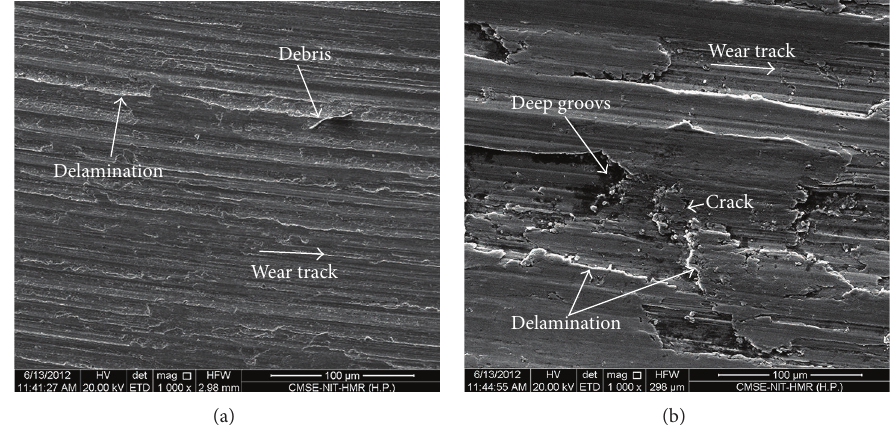
Figure 7: SEM of titanium (Grade 5) alloy after dry sliding conditions at sliding speed of 600rpm and applied normal load of (a) 50 N and (b) 90N,